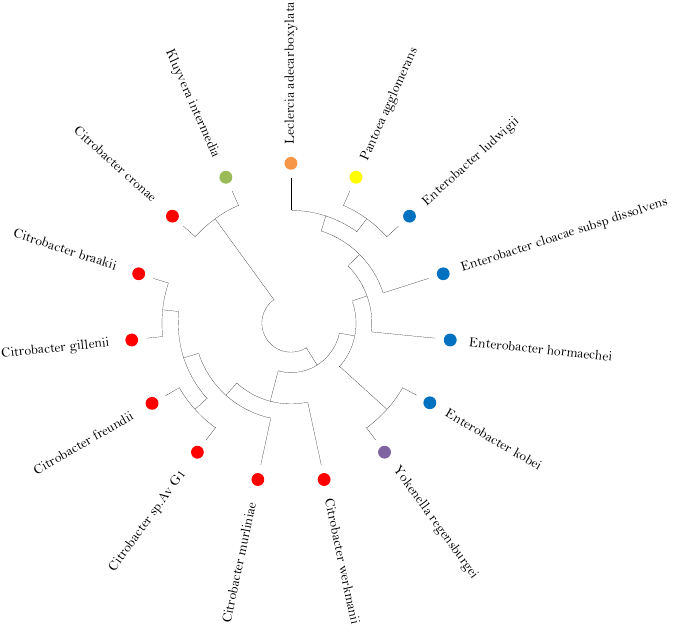
Figure 6. Circular phylogeny tree applying booststrap method with 500 replicas. In red is placed the genus Citrobacter, in blue the genus Enterobacter, orange Leclercia adecarboxylata , in purple Yokenella regensburgei , yellow Pantoea agglomerans, and in green Kluyvera intermedia .